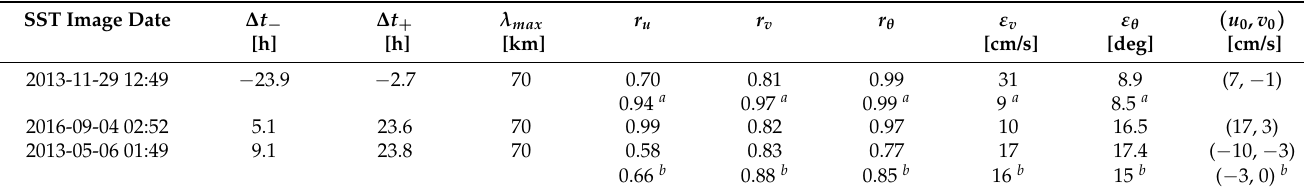
Table 1. Comparison between SQG-derived velocities and velocities derived from drifter trajectories: start ( ∆ t − ) and time ( ∆ t + ) of the drifter data used in hours to respect the SST image date; maximum wavelength ( λ max ), correlations for zonal ( r u ) and meridional ( r v ) velocities, and correlation for velocity direction ( r θ ); and RMSE of velocity ( ε v ) and direction ( ε θ ). SST Image